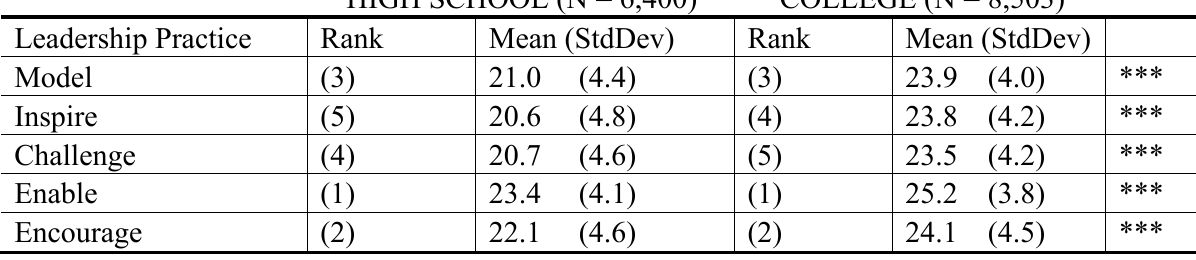
Table 6b. Comparisons between High School and College Respondents